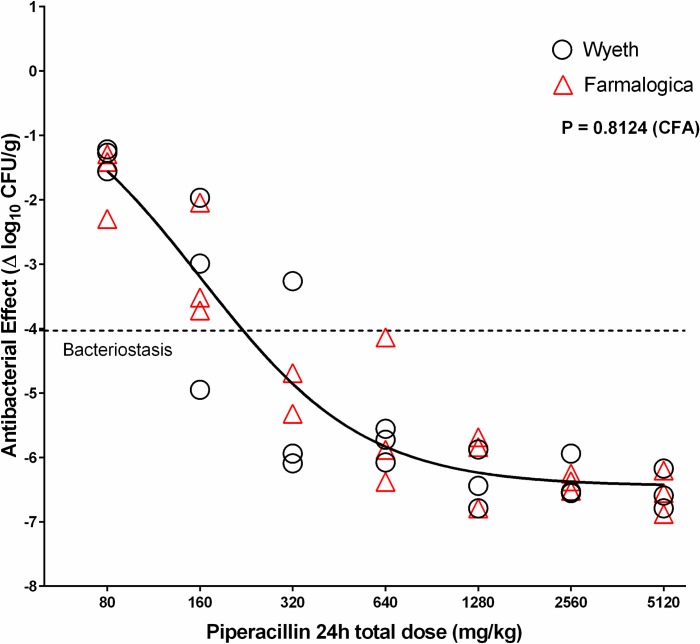
In vivo pharmacodynamics of innovator (Wyeth) and generic (Farmalogica) TZP against E. coli 35218Δbla.Therapeutic equivalence of generic TZP (Farmalogica) with the innovator (Wyeth) against E. coli 35218Δbla, a strain without β-lactamase (plasmid cured). After treatment of mice infected with the cured strain, TZP Farmalogica had a valid nonlinear regression fulfilling all the assumptions with highly significant PD parameters. Both products were described by a single curve, indicating that the generic is therapeutically equivalent to the innovator. As the strain has no β-lactamase, the effect is solely from the piperacillin component of TZP and indicates that the nonequivalence found against E. coli ATCC 35218 is due to tazobactam.